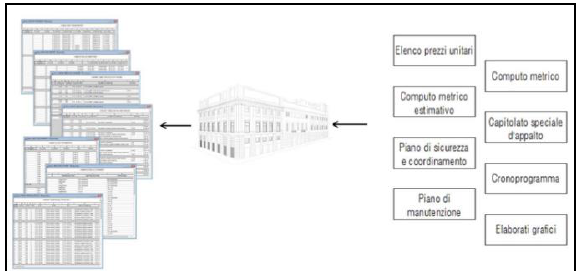
Figure 11. Workflow from BIM model to documentation